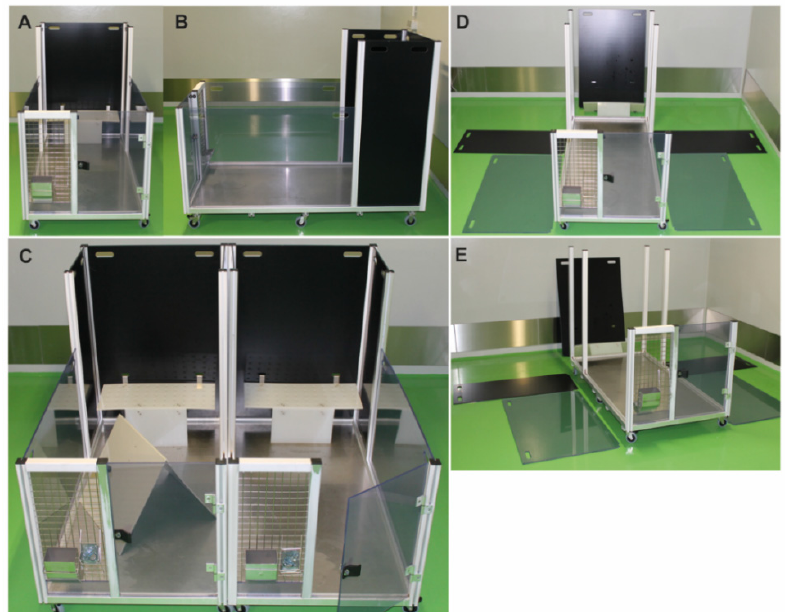
Figure 1. Mobile-R-pen housing equipment front view ( A ) and lateral overview ( B ). Water bottles, food containers, or additional enrichment can be added to the gridded front panel of each